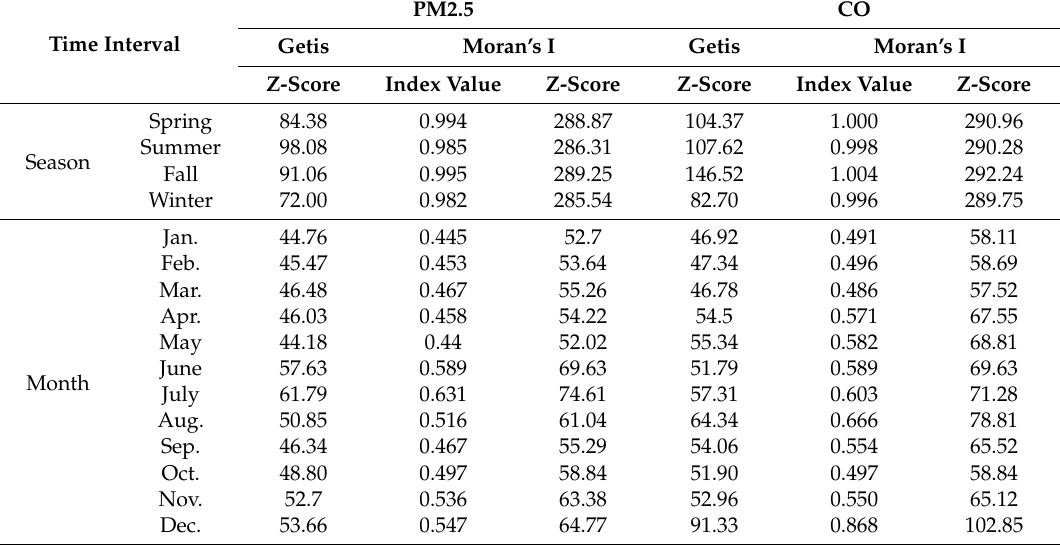
Table 2. Monthly and seasonal results of global Moran’s I and Getis-Ord General G indices on carbon monoxide (CO) and fine particulate matter (PM 2.5